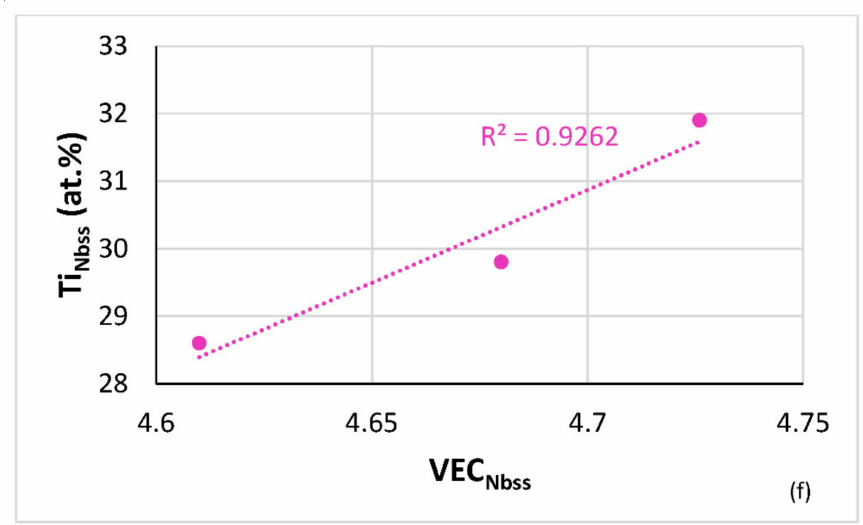
Figure 4. ( a ) Ti versus Si and ( b ) B versus Si content of the Nb ss in the alloys TT1 [12], TT2, TT3, TT4 and TT8 where the data for HT alloys is shown in green. In ( a ) the R 2 values are given for the linear or parabolic fit of data and in ( b ) the R 2 values are for the parabolic fit of data, where blue filled circles correspond to Ti-rich Nb ss and red to normal Nb ss in AC alloy. ( c ) Element X versus Cr in Nb ss , data for X = B (brown) or Ti (purple) in the Nb ss of the HT alloys TT2, TT4 and TT8. ( d ) Ti + B + X (X = Al, Cr) versus VEC of Nb ss in the HT alloys TT2, TT3, TT4 and TT8, purple X = Al, alloys TT3, TT4, TT8, pink X = Cr, alloys TT2, TT4, TT8, ( e ) Ti + Cr versus VEC and ( f ) Ti versus VEC of Nb ss , HT alloys TT2, TT4,